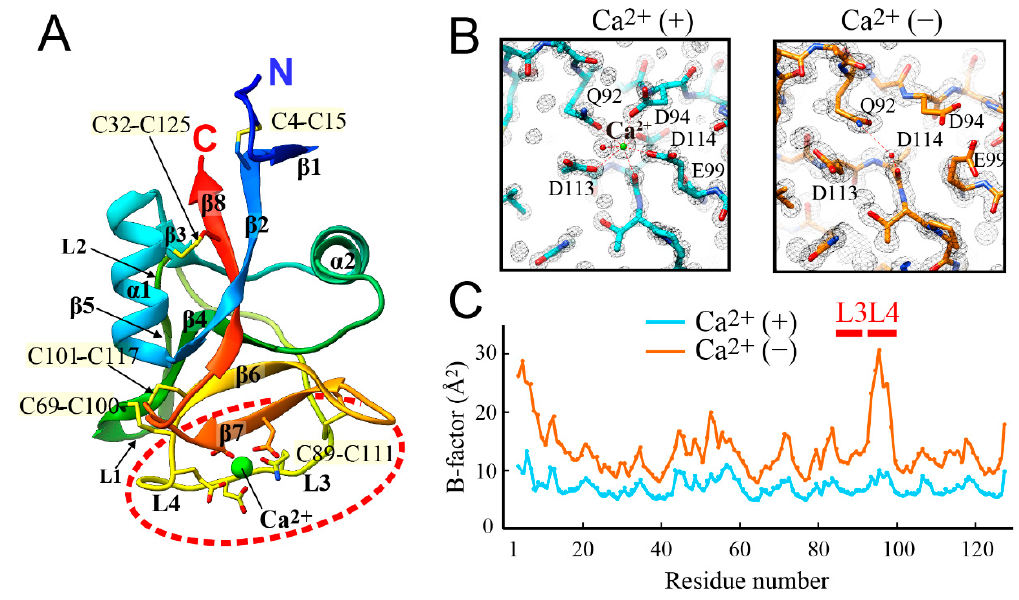
Figure 3. X-ray crystal structure of jsAFP. ( A ) The present determined structure of jsAFP in the Ca 2 + -bound state. The backbone conformation is represented by ribbon model with rainbow color. The model also includes the sticks showing five disulfide-bonds and 5 Ca 2 + -coordinating residues (Q92, D94 E99, D113, and D114). The Ca 2 + -binding site functioning as IBS is indicated by a red hatched circle. ( B ) Expanded views of the Ca 2 + -binding site of jsAFP with and without Ca 2 + . The 5 residues (sticks) are superimposed to the electron density map (black mesh). The Ca 2 + -bound form (left) only functions as IBS. ( C ) Comparison of B-factor (Å 2 ) of the C α -atom positions along the sequence of jsAFP between the Ca 2 + -bound (cyan) and -free (orange) states. The locations of the Ca 2 + -binding loops L3 (C89 − Q92) and L4 (D94 − E99) are indicated.